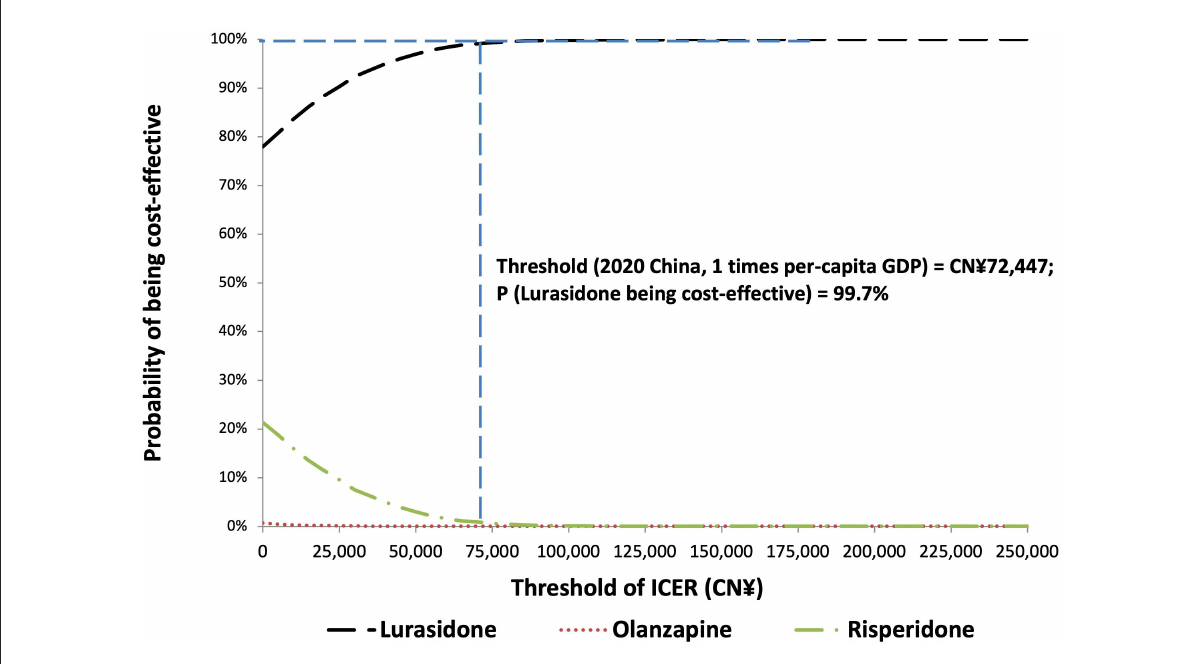
FIGURE3 Cost-effectiveness acceptability curve for probabilistic sensitivity analysis. GDP, gross domestic product; ICER, incremental cost-effectiveness